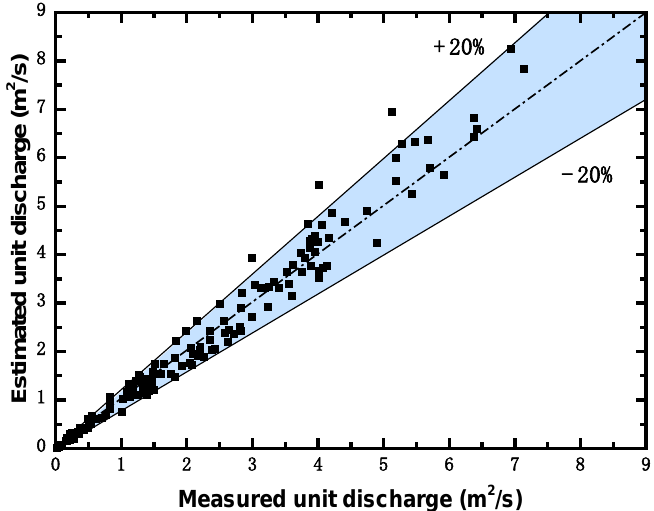
Figure 15. Comparison of estimated and measured unit discharge.